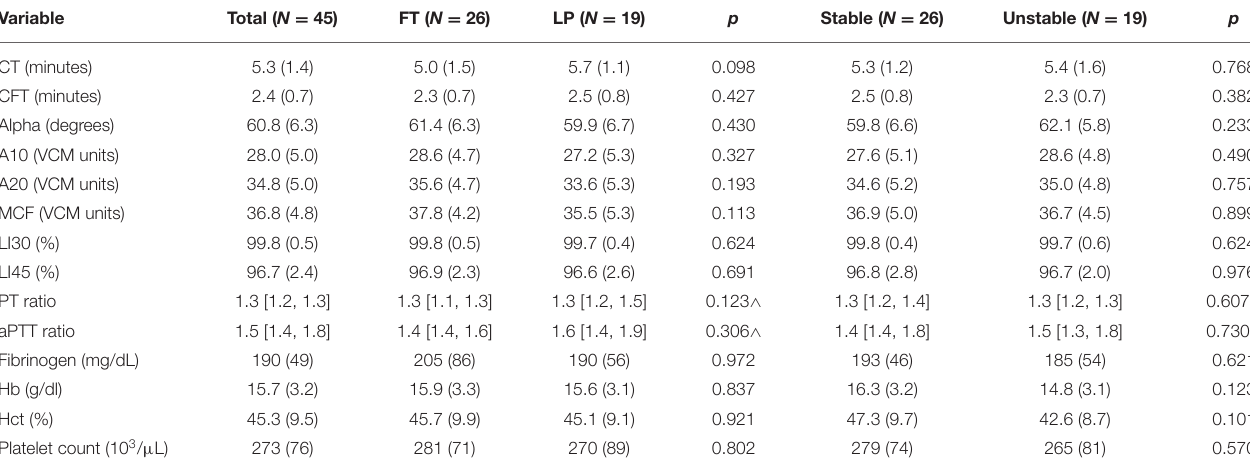
TABLE 2 | VCM profiles, coagulation tests, and blood count of the neonatal population. Variable